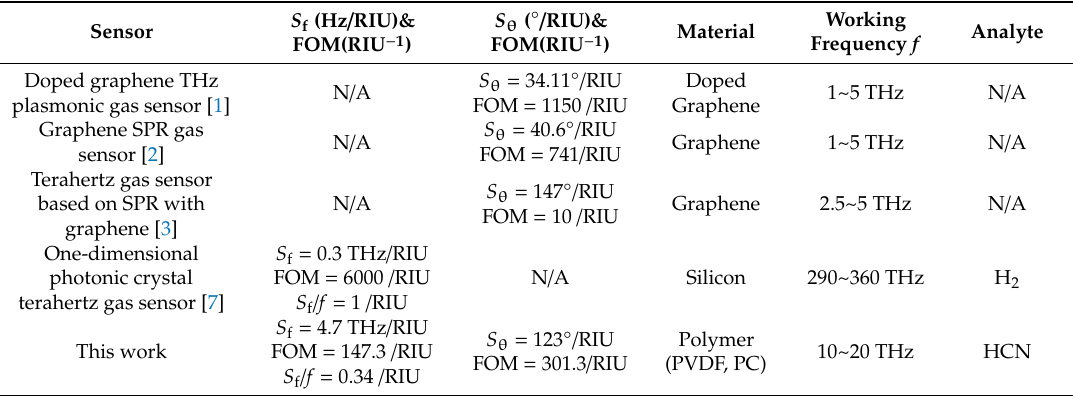
Table 1. Comparison of the recently reported THz gas